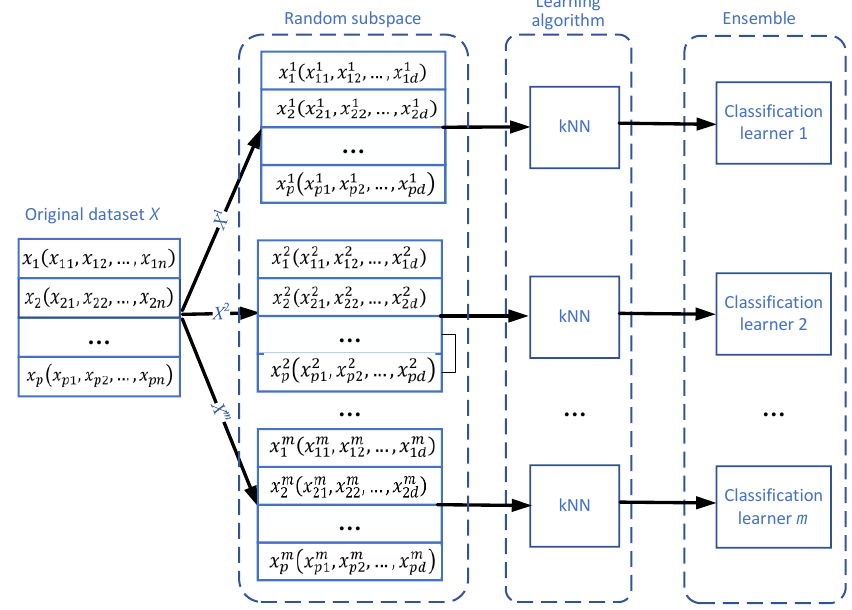
Figure 2. The diagram of the basic random subspace algorithm .